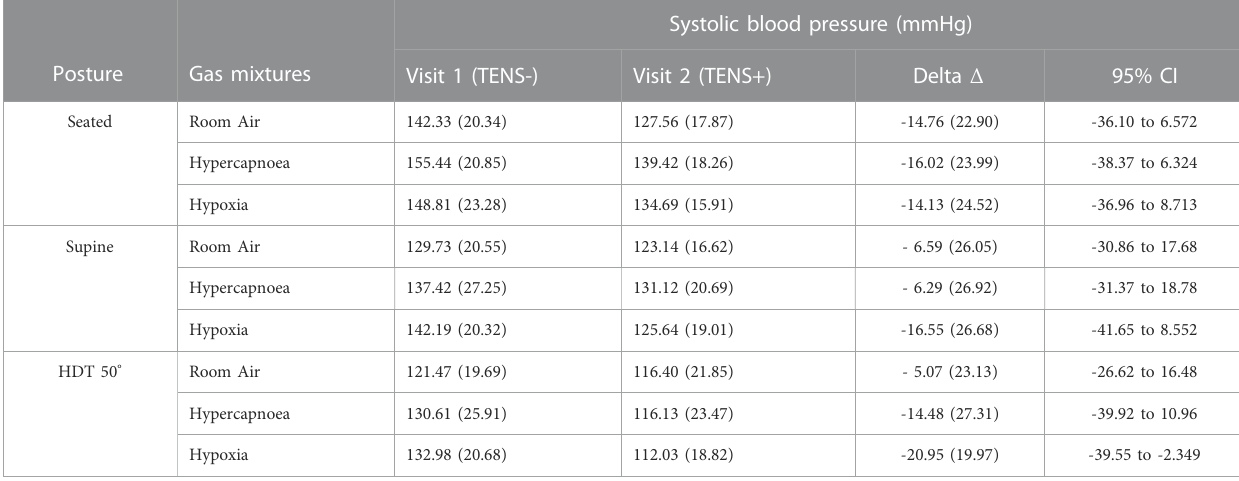
TABLE1Systolicbloodpressurewithandwithoutelectricalstimulationinseated,supineandHDTpostures.Dataarepresentedasmean(SD).HDT,headdowntilt. TENS-, electrical current off. TENS + electrical current turned on. 95% CI, 95% con fi dence interval.